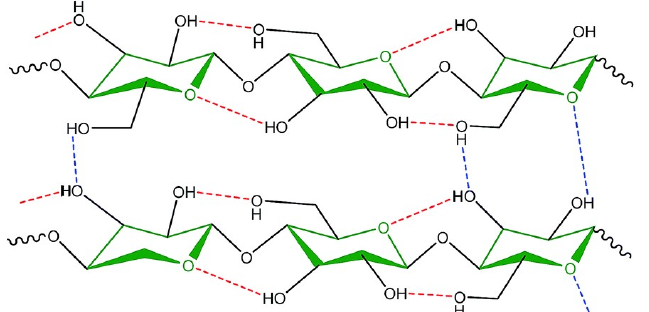
Figure 8. Inter- and intra- molecular hydrogen bonds in the molecular structure of cellulose [58] .